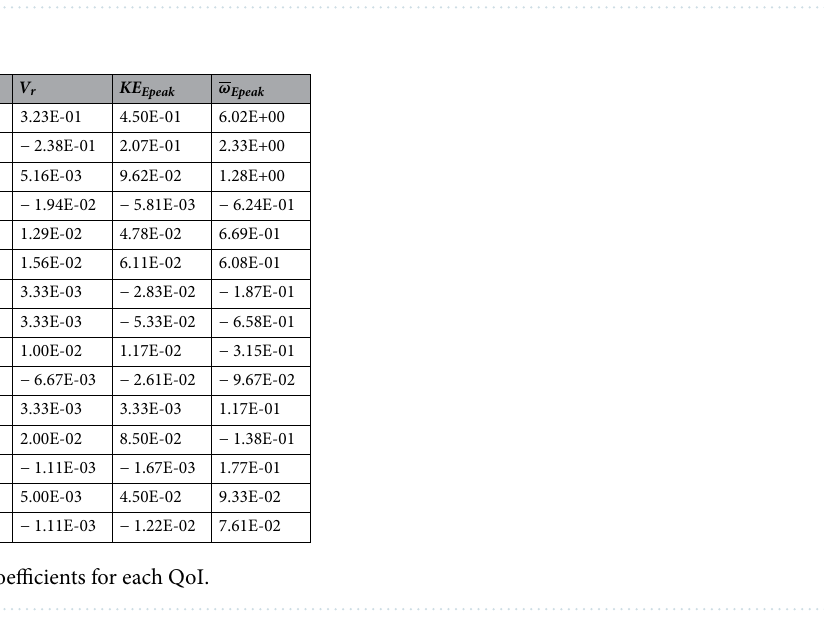
Table 1. Probabilistic distributions associated with the selected governing parameters.